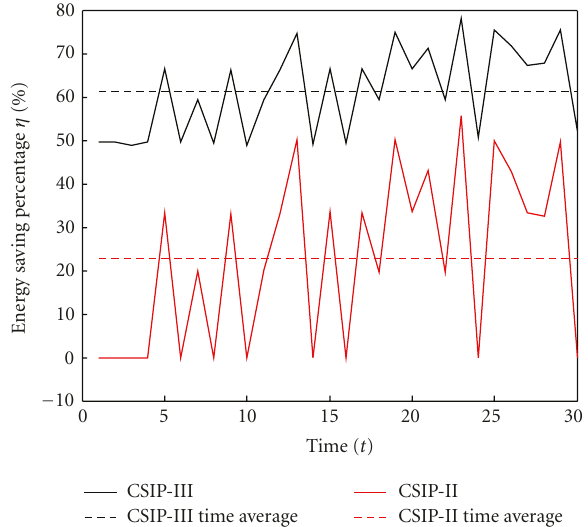
Figure 10: Instantaneous energy saving percentage of CSIP-III and CSIP-II relative to CSIP-I during the tracking process. x -axis unit: second; y -axis unit: percentage.